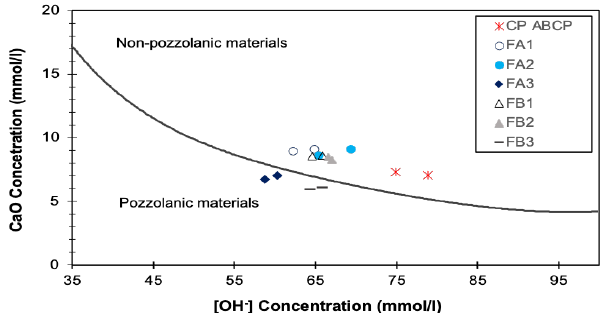
Figure 3. Result of the chemical titration test, according to standard NP EN